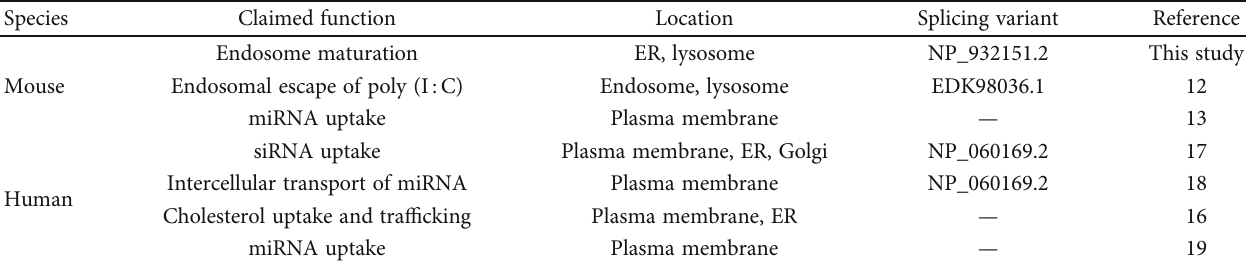
Table 1: Locations and functions of